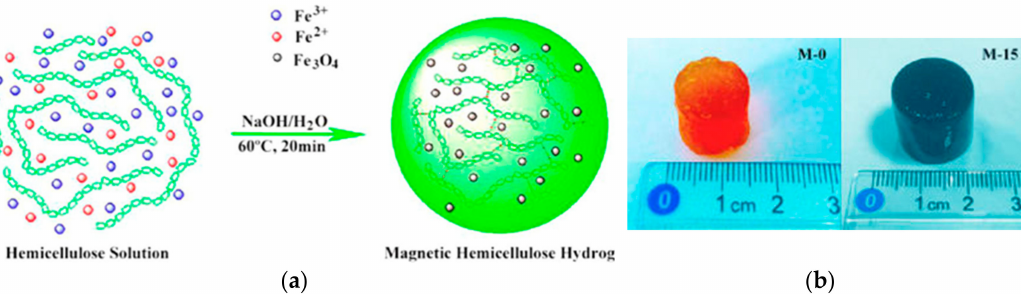
Figure 10. Fe 3 O 4 nanoparticles synthesized in situ. ( a ) Proposed fabrication of magnetic field-responsive hemicellulose hydrogels in basic media. ( b ) Prepared hemicellulose hydrogel (M-0) and magnetic-responsive hemicellulose hydrogel (M-15) (reproduced from [145] under open access